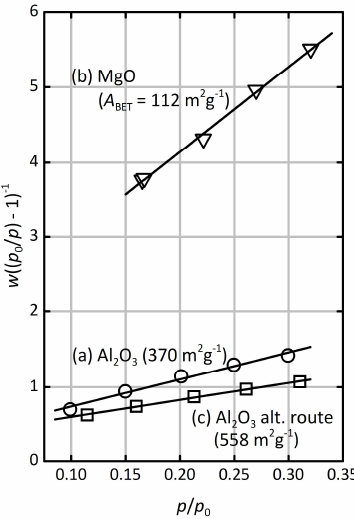
Figure 3. BET plots of Kr physisorption data of porous metal oxide layers: ( a ) Al 2 O 3 layer (1.77 μm thickness); ( b ) MgO (0.646 μm); ( c ) Al 2 O 3 (prepared by pre-mixing the polymer).